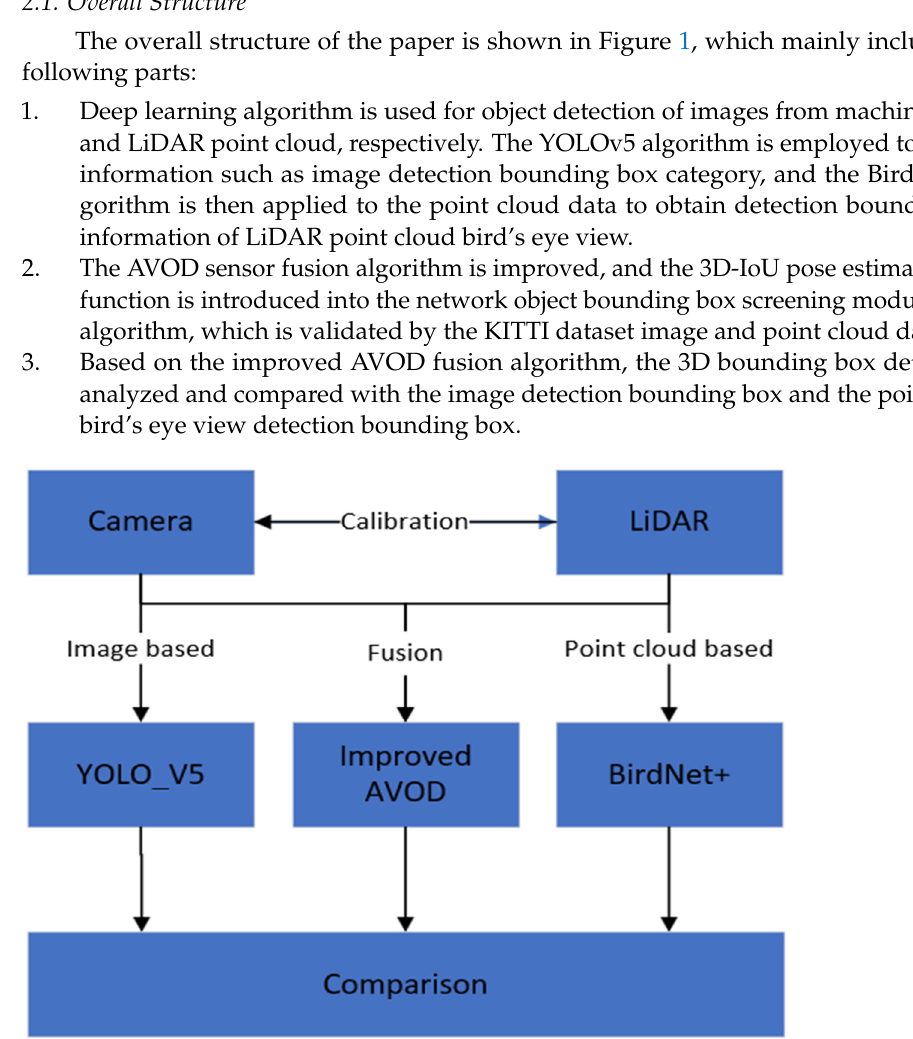
Figure 1. Overall